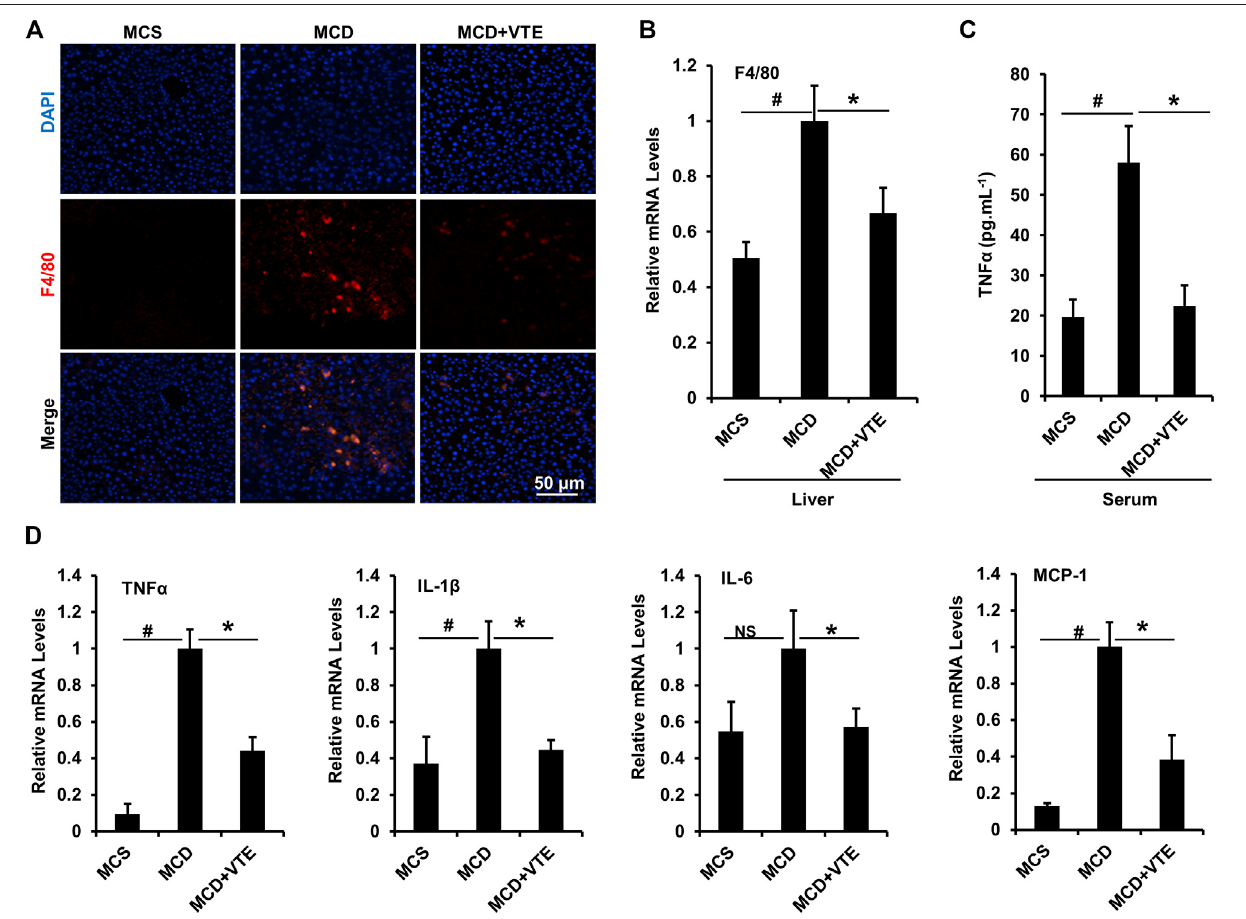
FIGURE 4 | VTE inhibits hepatic in fl ammation in MCDD-fed mice. Male C57BL/6J mice (20 ± 2 g) were fed an MCD diet in the presence and absence of VTE (1 g 100 g − 1 diet) for 6 weeks (A) F4/80 immuno fl uorescence analysis in the livers from the MCS diet-, MCD diet- and MCD + VTE-fed mice. Scale bars, 50 μ m (B) F4/80 mRNAlevelsinlivers; n (cid:2) 5pergroup (C) ELISAanalysisofserumTNF α levels; n (cid:2) 5 – 6pergroup (D) RelativemRNAexpressionofpro-in fl ammationgenesinmouseliver; n (cid:2) 3 – 5 per group. β -ACTIN was used as an internal control for normalizing the mRNA levels. Data are statistically analysed as means ± SEM. # p < 0.05, MCD compared with the MCS group of mice. * p < 0.05, MCD compared with the MCD + VTE group. NS, no signi fi